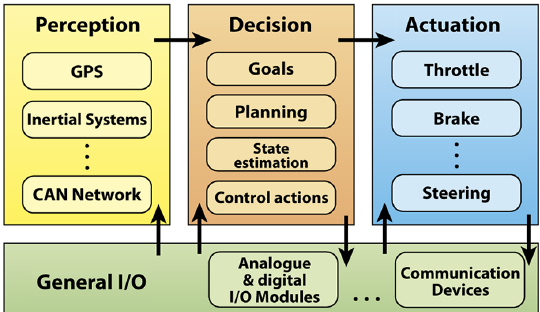
Fig. 1. Scheme of AUTOPIA’s control